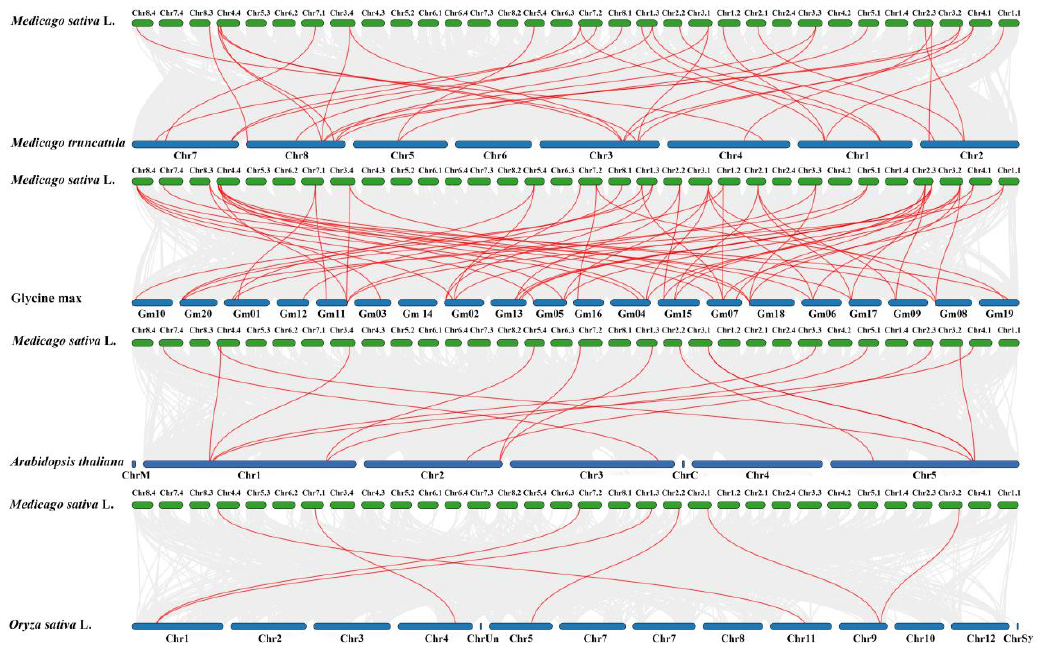
Figure 6. Synteny analyses MsSPL genes with four representative plant species. Red lines highlight syntenic SPL gene pairs within alfalfa and other plant genomes.